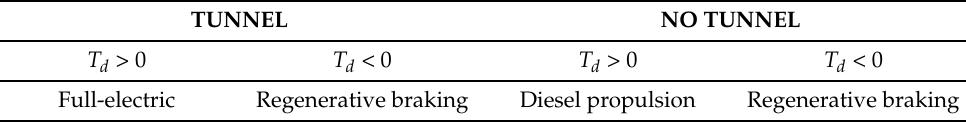
Figure 9. Block model structure of the operative modes. Table 1. Summary of operative